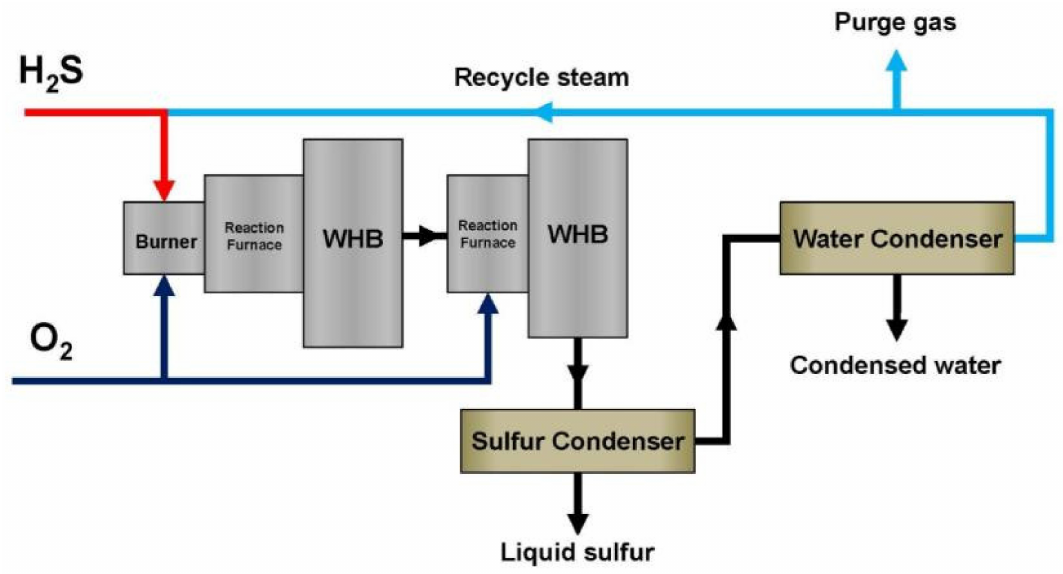
Figure 3. COPE ® Technology (Kingswinford, UK) flow sheet diagram (adapted from